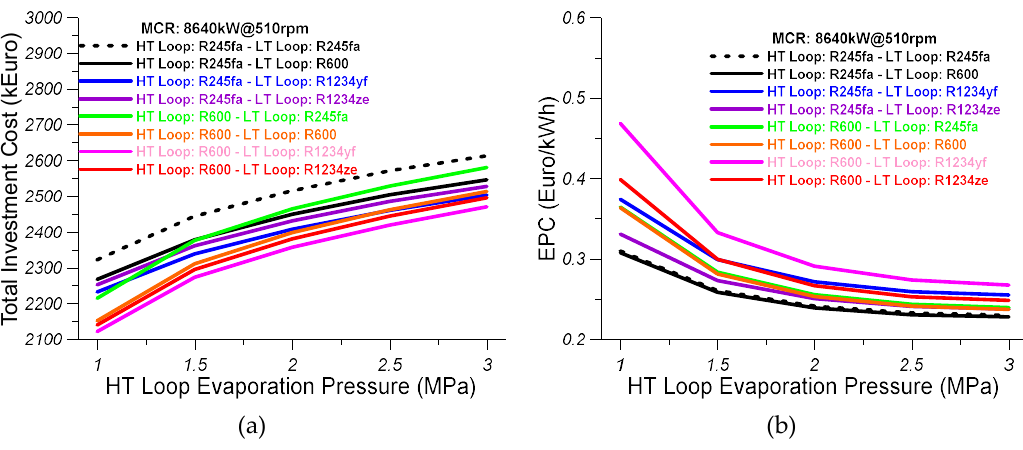
Figure 8. (a) Effect of evaporation pressure of the HT loop on the total investment cost of the regenerative dual-loop ORC; (b) Effect of evaporation pressure of the HT loop on the electricity production cost (EPC) of the regenerative dual-loop ORC. The results are given for all the pairs of organic mediums that are examined in the present study.